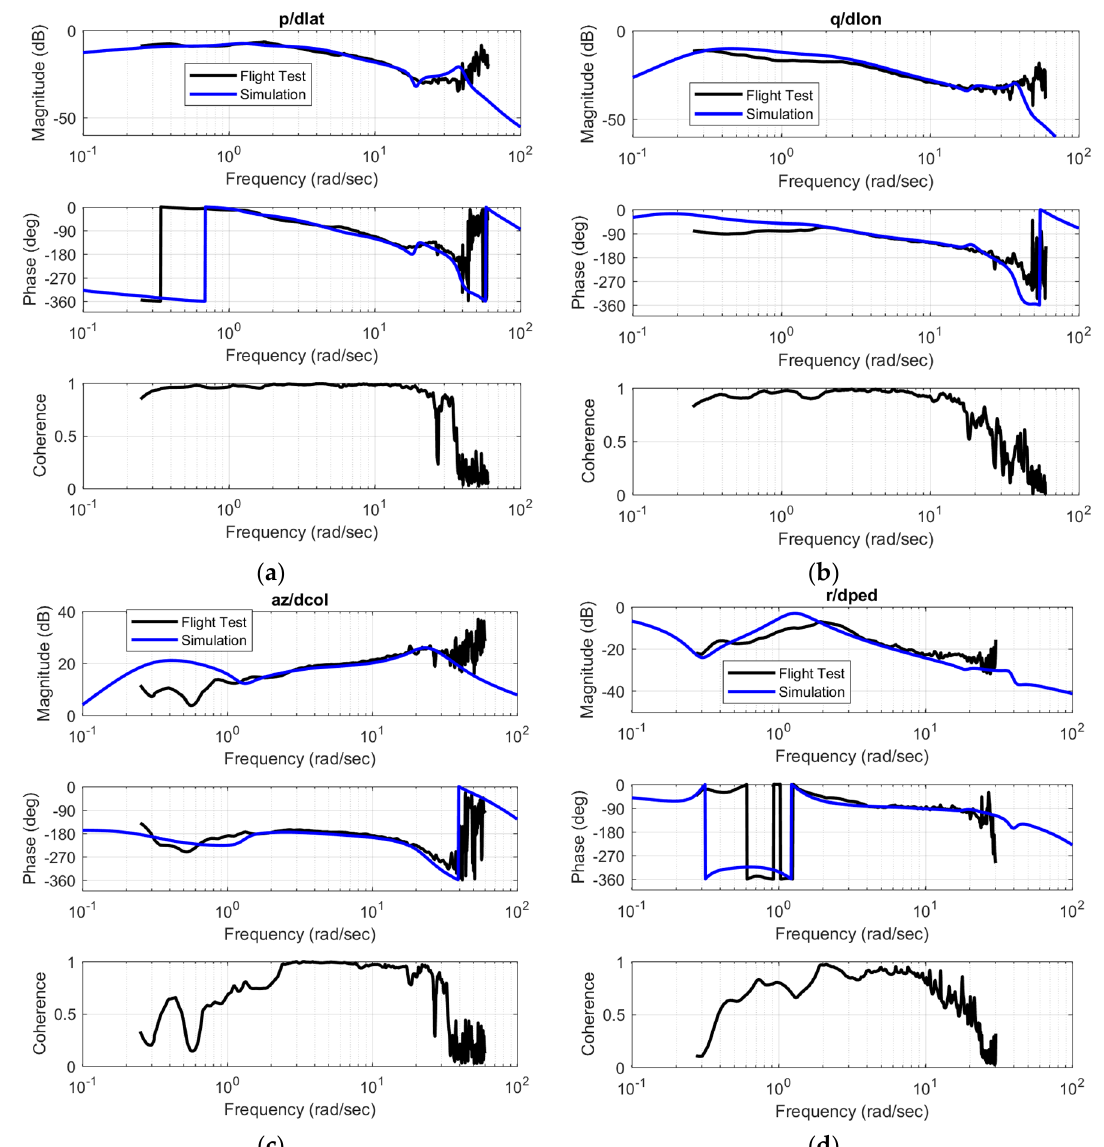
Figure 3. On-axis frequency responses from flight test [19] and the simulation model at 80 kts forward airspeed, showing good correlation from 0.7 to 30 rad/s, ( a ) roll rate due to lateral cyclic input; ( b ) pitch rate due to longitudinal cyclic input; ( c ) vertical acceleration due to collective input; ( d ) yaw rate response due to pedal input.